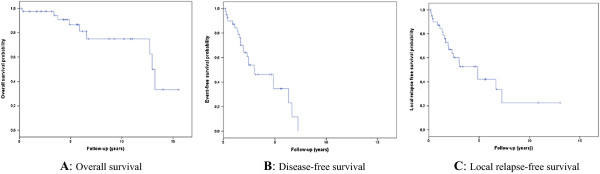
Survival curves.